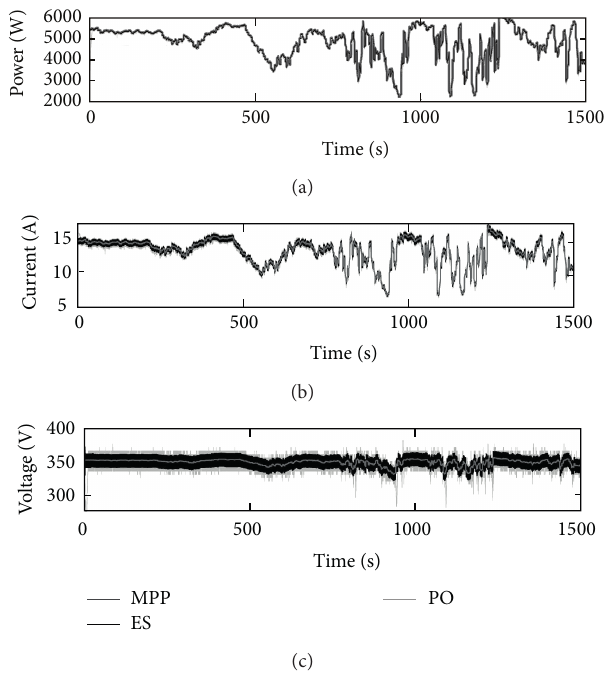
Figure 4: Comparison of voltage controlled P&O and ESC MPPT controller